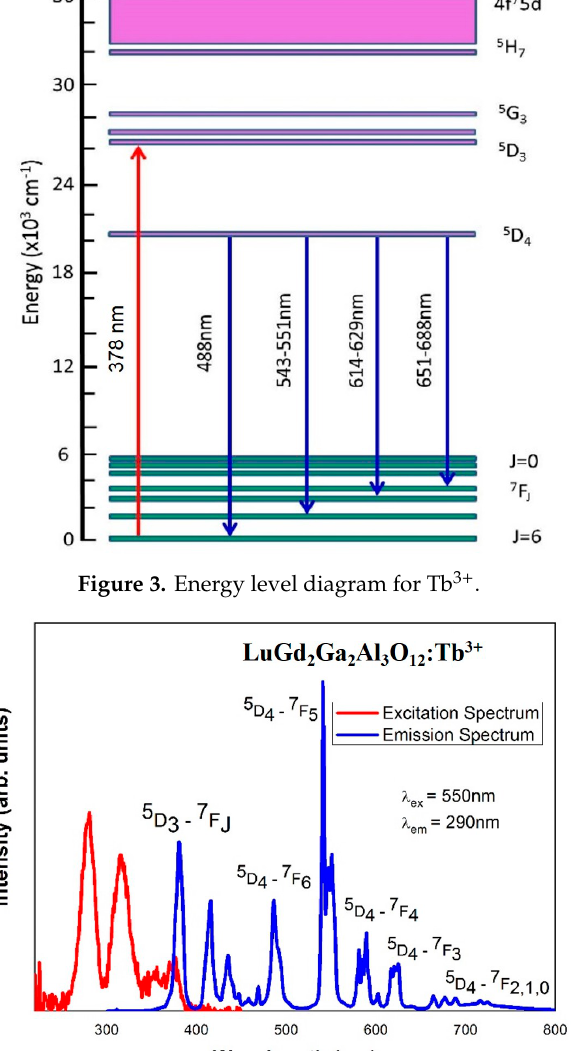
Figure 5. UV induced emission peaks of LuGd 2 Ga 2 Al 3 O 12 :Tb 3+ phosphor.